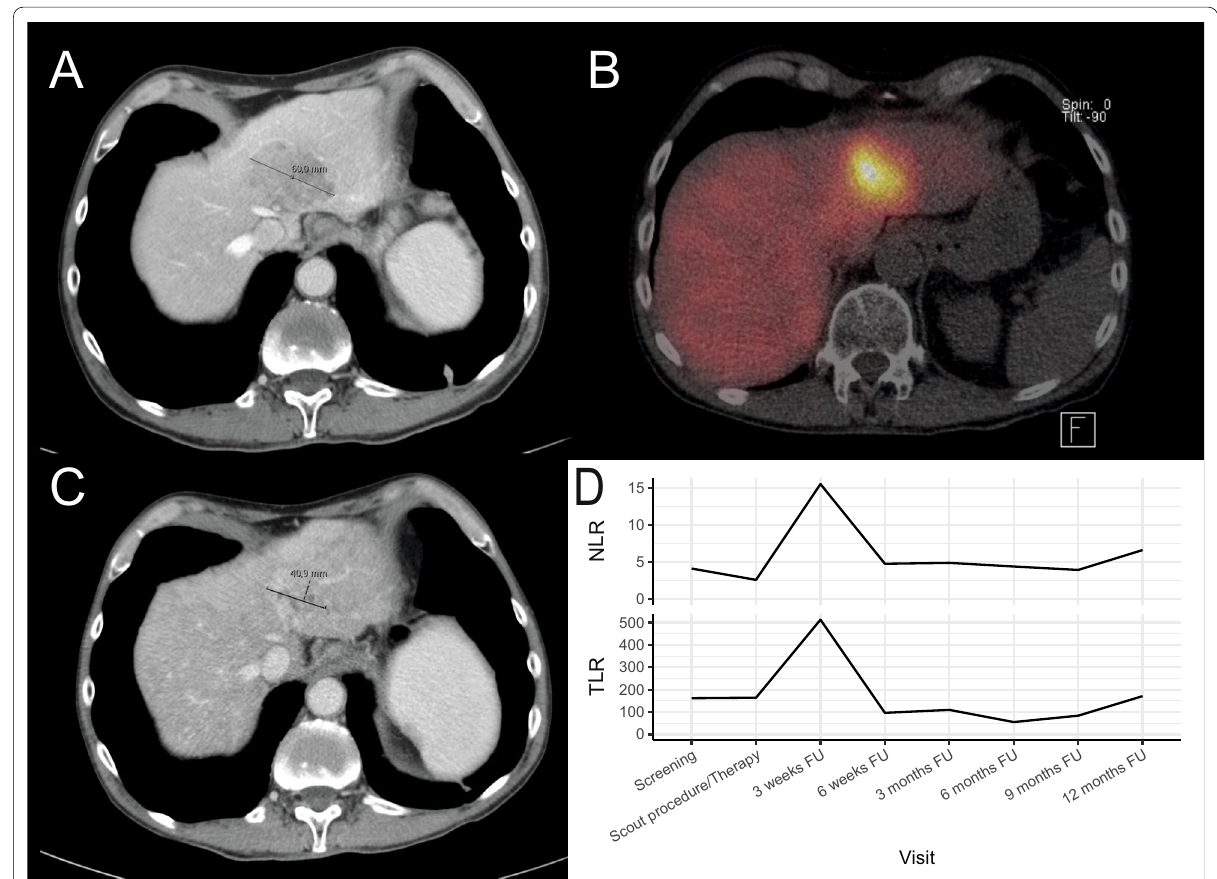
Fig. 5 A male patient with hepatic neuroendocrine tumor metastases, with the largest lesion measuring 60 mm at screening ( A ), was treated with whole-liver [ 166 Ho]-radioembolization ( B ). After 3 months partial response was observed, with the largest lesion measuring 41 mm ( C ). A clear peak in NLR and TLR can be observed at 3 weeks follow-up ( D ). FU